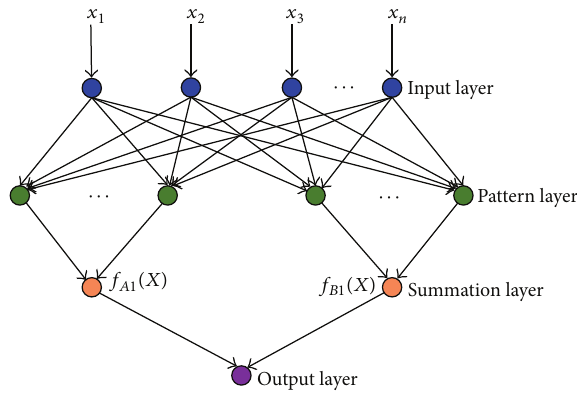
Figure 6: The basic PNN